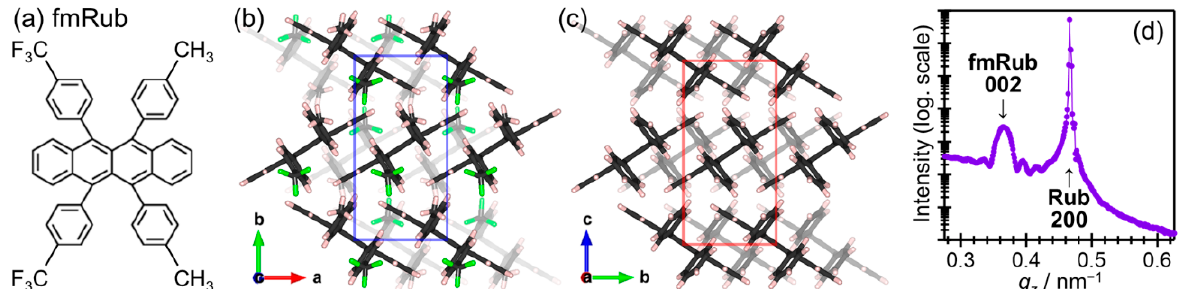
Figure 13. ( a ) Molecular structure of fmRub. ( b ) Molecular arrangement of the fmRub (001) surface. The surface unit cell is indicated as a blue rectangle. ( c ) Molecular arrangement of the RubSC (100) surface. The surface unit cell is indicated as a red rectangle. ( d ) Out-of-plane XRD profile of a RubSC sample covered with 50 nm-thick fmRub.